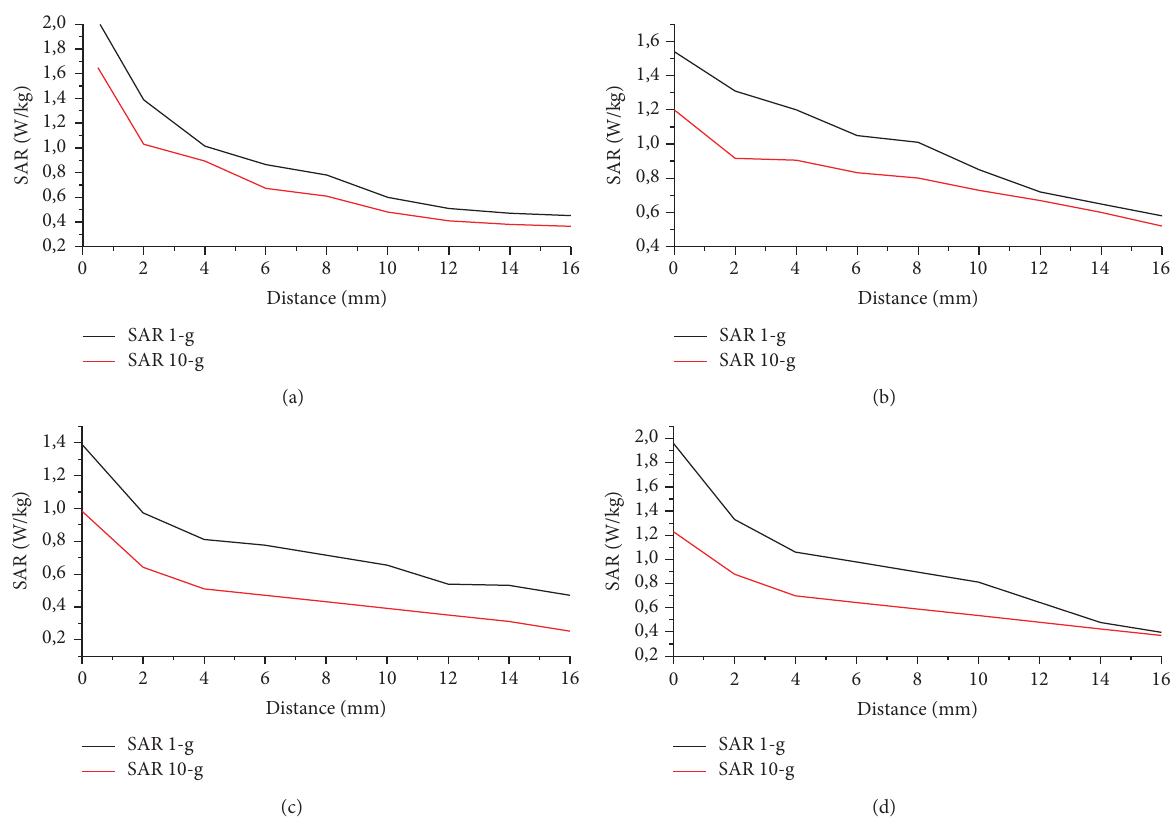
Figure 17: SAR variation in terms of the distance between the PIFA and the head: (a) at 790 MHz, (b) at 1870 MHz, (c) at 2550 MHz, and (d) at 3400